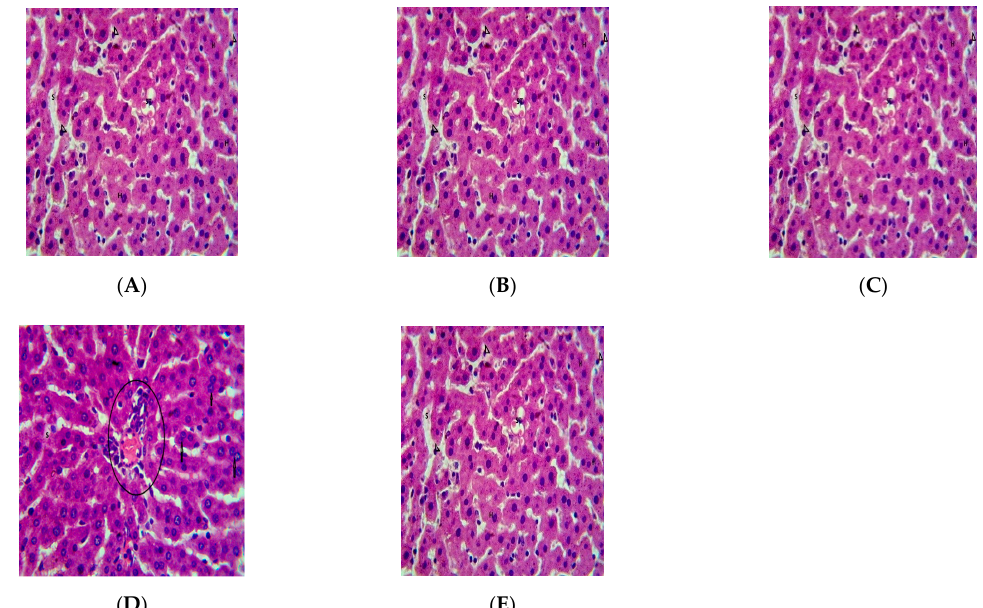
Figure 5: Photomicrograph of liver tissue section of Wistar rats repeatedly dosed with ( A ) 62.5 mg/kg bw, ( B ) 125 mg/kg bw, ( C ) 250 mg/kg bw of P. dactylifera essential oil and ( E ) control showing steatosis (ST), well arranged hepatocytes (H) separated by the sinusoids (S) (×400 H and E Staining); ( D ) 500 mg/kg bw P. dactylifera essential oil showing portal triad with mild periportal hepatitis, hepatocytes showed bi-nucleation (arrow) (×400 H and E Staining).